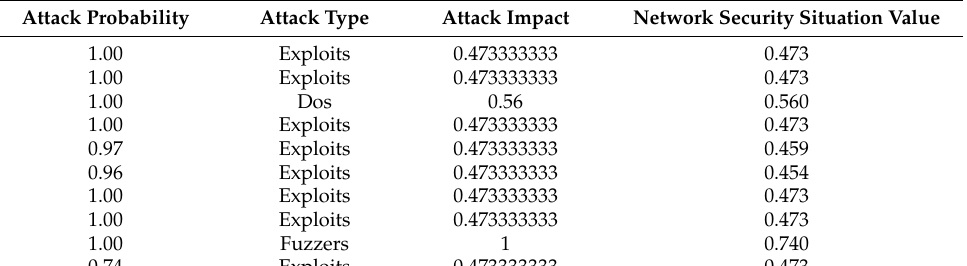
Table 10. Network security situation values 715–725.